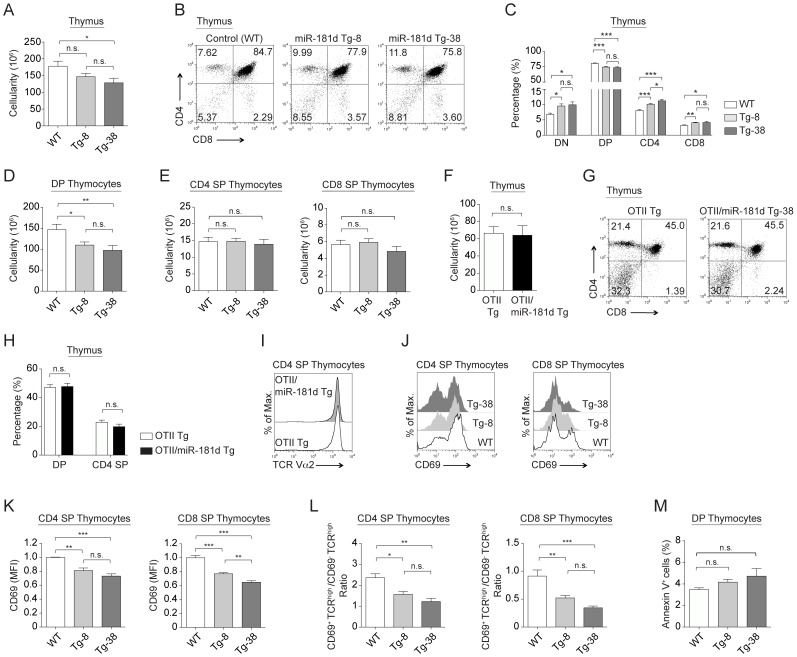
MiR-181d over-expression reduces the number of DP thymocytes.(A) Total thymus cellularity in the control and miR-181d Tg mice. (B) Representative plots show CD4 by CD8 profiles of thymocytes in the control and miR-181d Tg mice, analyzed by FACS. (C) Average percentages of thymocyte subsets (DN, DP, CD4 SP, and CD8 SP) from the control and miR-181d Tg mice. (D) Absolute cell numbers of DP thymocytes. (E) Absolute cell numbers of CD4 SP (left) and CD8 SP (right) thymocytes. (A–E) Data are from WT (n = 18), Tg-8 (n = 25), and Tg-38 (n = 16) mice. (F) Total thymus cellularity of the OTII Tg and OTII/miR-181d Tg-38 mice. (G) Total thymocytes were stained for CD4 and CD8, and analyzed by FACS. (H) Average percentages of DP and CD4 SP thymocytes are shown. (I) Histogram shows the surface expression of TCR (TCR Vα2) gated on CD4+CD8− SP thymocytes from the OTII Tg (dark gray) and OTII/miR-181d Tg-38 mice (black line). (F–I) Data are from at least 2 mice per group. Each bar is the mean +/− SEM (n.s.  =  non-significant, *p<0.05, **p<0.01, ***p<0.001; Two-tailed unpaired Student's t-test). (J) Histograms show CD69 expression on CD4 SP and CD8 SP thymocytes from the WT (white), Tg-8 (light gray), and Tg-38 (dark gray) mice. (K) Relative MFI (Mean Fluorescence Intensity) levels of CD69 on SP thymocytes. (L) Ratio of the CD69+TCRβhigh to CD69−TCRβhigh thymocyte numbers shown for CD4 SP and CD8 SP thymocytes. (M) Average percentages of Annexin V+ cells gated on DP thymocytes. (J-M) Data are of at least 3 mice per group. All bar graphs represent the mean +/− SEM values (n.s.  =  non-significant, *p<0.05, **p<0.01, ***p<0.001; One-way ANOVA followed by Tukey's post-hoc test).